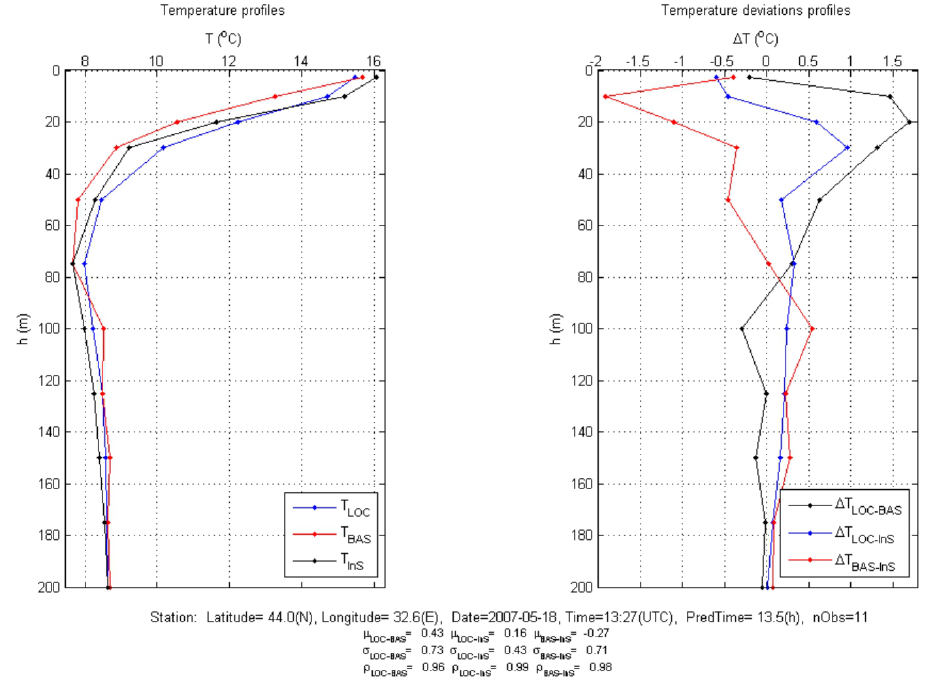
Fig. 9. The temperature profiles (left) derived from coastal model (blue), basin-scale model (red) and in-situ measurements (black) and the deviations of the local (blue) and basin-scale (red) models from observations and the difference between local and basin-scale models (right).